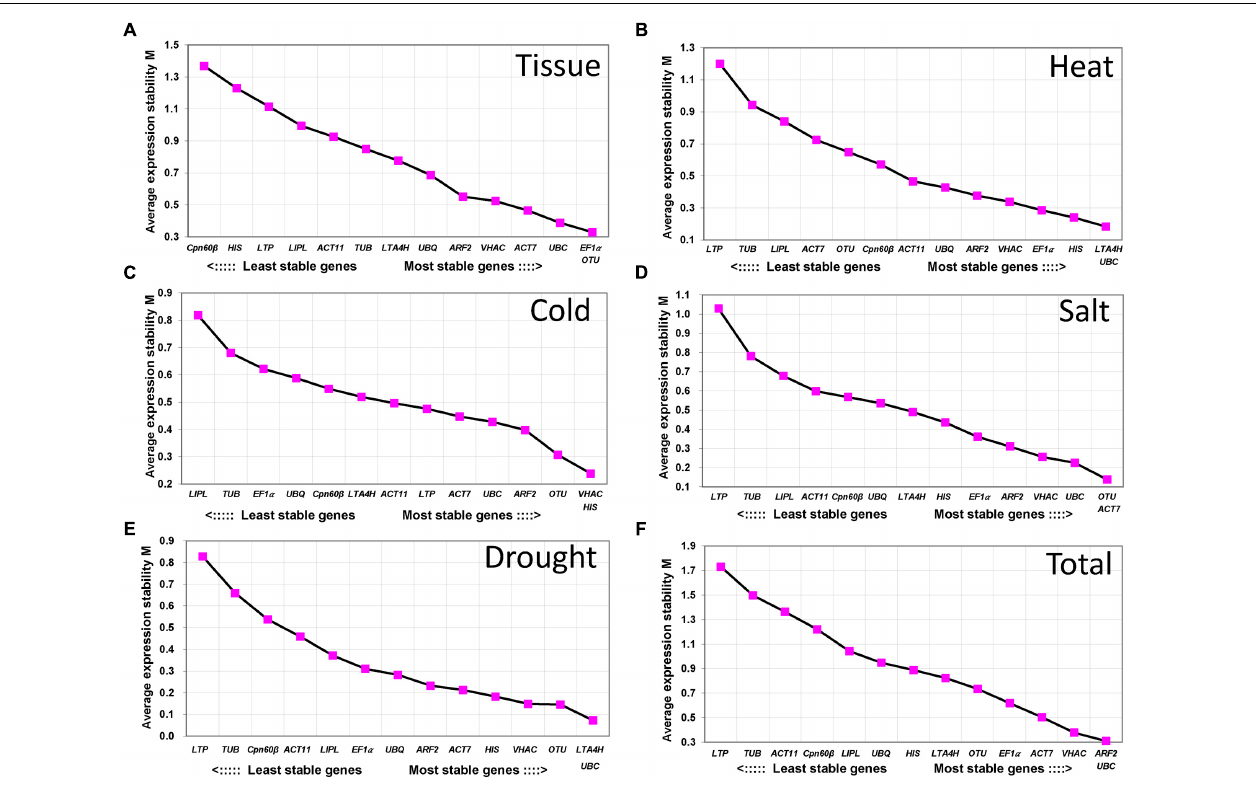
FIGURE 2 | Average expression stability values ( M ) and ranking of the candidate RGs calculated using geNorm. M -value s and ranking of the candidate RGs in tissue (A) , heat stress (B) , cold stress (C) , salt stress (D) , drought stress (E) , and total sample (F) . A lower value of the average expression stability indicates more stable expression.